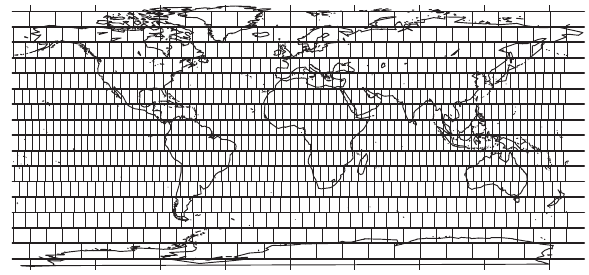
Figure 1. 500,000 meter equal area gridding scheme for geographic coverage measure superimposed on a geographic map of the present day. This measure is equal to the number of equal area cells in a paleolatitude strip with fossil occurrences of our target taxa.